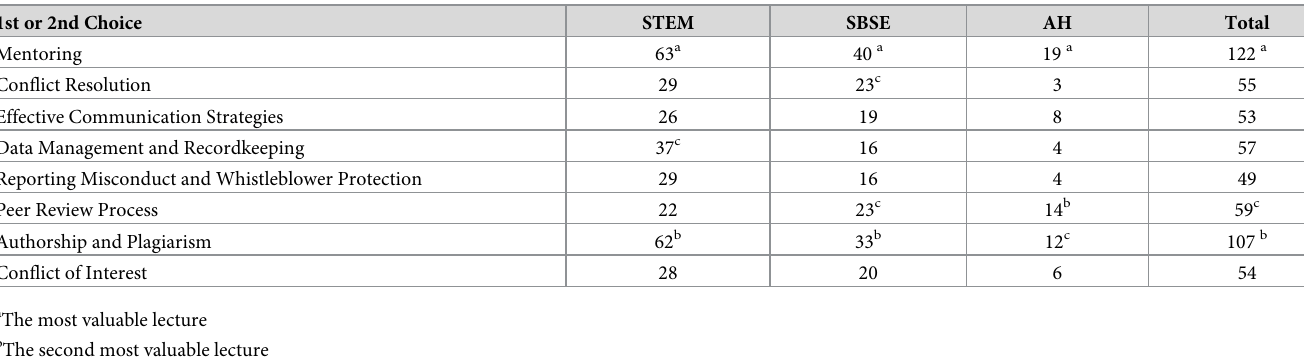
Table 3. Stage II: Ranking of